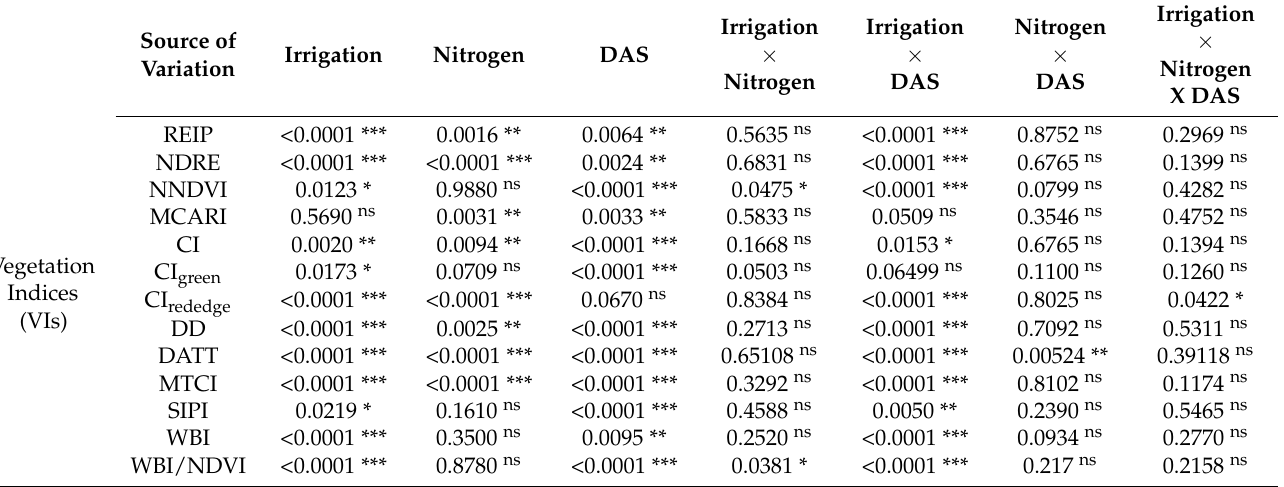
Table 2. The analysis of variance of 13 vegetation indices (VIs) for different irrigation regimes, nitrogen levels, and the day after sowing (DAS) of sweet maize.